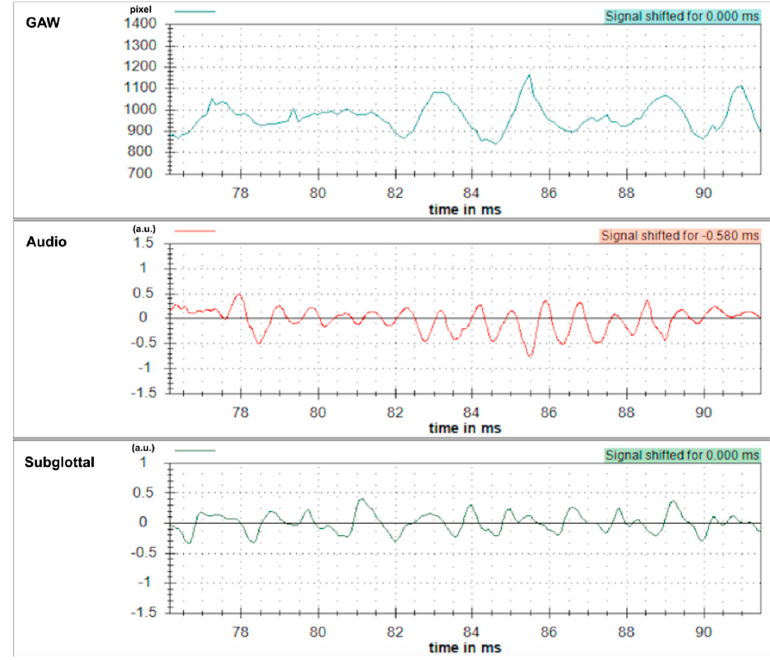
Figure 6. GAW, audio signal, subglottal frequencies in aperiodic vocal fold vibrations i.e., no periodicity recognizable in the GAW.